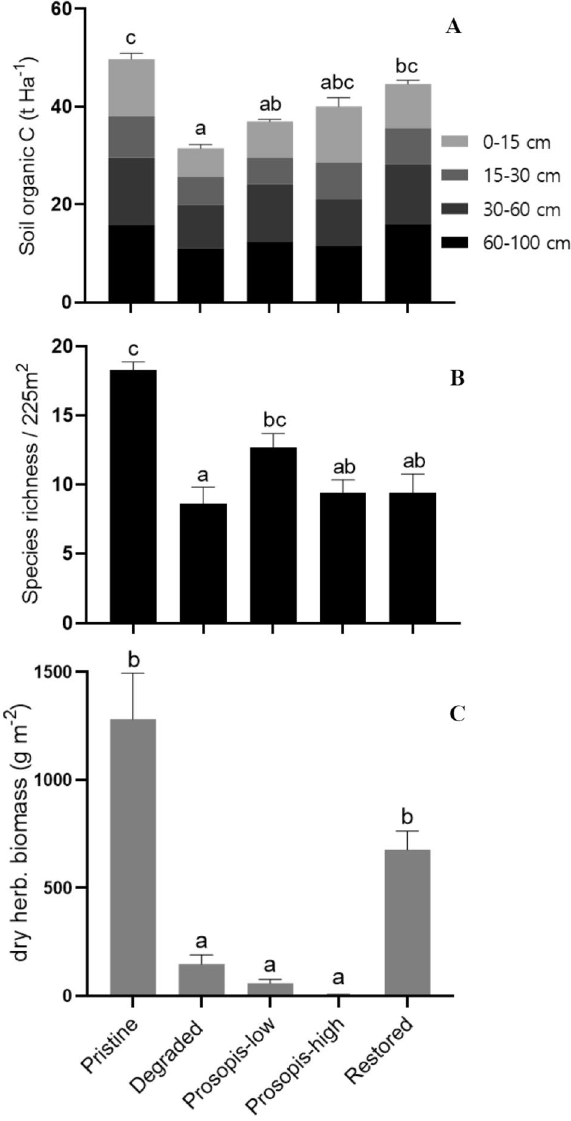
Figure 2. Total soil organic carbon in tonnes per hectare at four soil depth increments from surface to 1 m below ground ( A ), species richness per plot (225 m 2 ) ( B ) and dry weight of herbaceous vegetation g m -2 ( C ), shown for the five land cover types. The error bars indicate standard errors. Land cover types sharing a letter are not significantly different at α = 0.05.